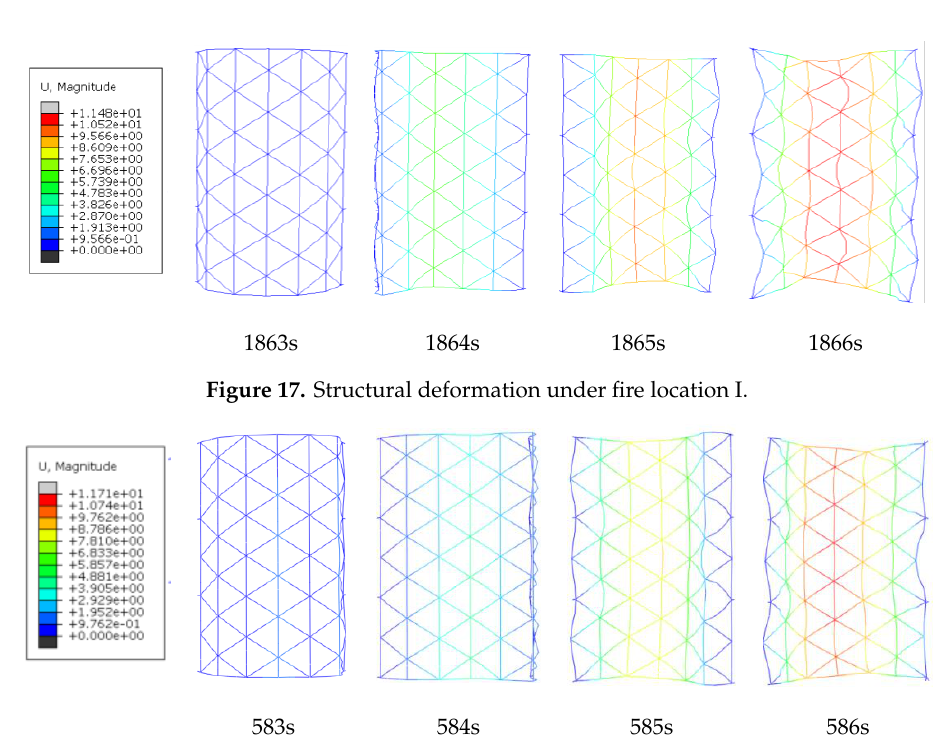
Figure 19. Structural deformation under fire location III. When the maximum fire source power is 20 MW, the structure has different failure modes and fire durations depending on the location of the fire source. The maximum displacement point of the reticulated shell under a normal temperature load is located at the highest midpoint of the roof. The equivalent displacement is 0.09 m. The structure remains in an overall stable state. When the fire source is in the center at the ground level, as shown in Figure 17, the structure remains basically stable during the first 1860 s of the fire. At 1863 s, the components on the left side yield first, and then the upper reticulated structure begins to collapse from the middle. After a few seconds, the cylindrical reticulated shell collapses completely at 1866 s, while the maximum displacement of the node in the middle of the roof is up to 11.63 m. The structure reaches its bearing capacity limit at 1863 s, and the structure is completely destroyed. The fire resistance limit of the structure in these fire conditions is thus 1863 s. When the fire source is set at the midpoint of the longitudinal side, as